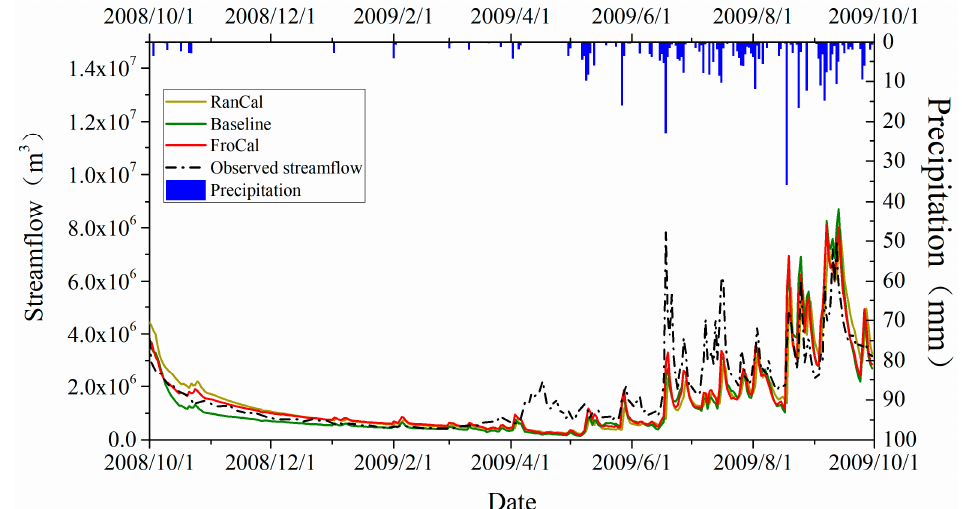
Figure 6. Comparison of the effects of spatially stratifying frozen ground type (FroCal) and random spatial stratification (RanCal) on the daily streamflow simulations in the period of 1 October 2008 to 30 September 2009.